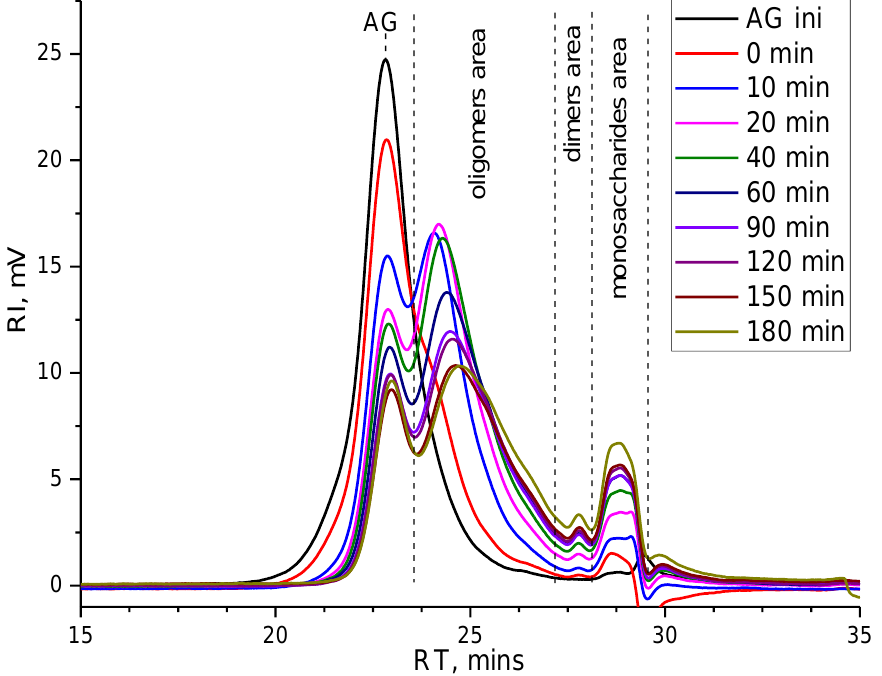
Figure 6. Gel permeation chromatogram of the arabinogalactan catalytic depolymerization products at a temperature of 110 °C.